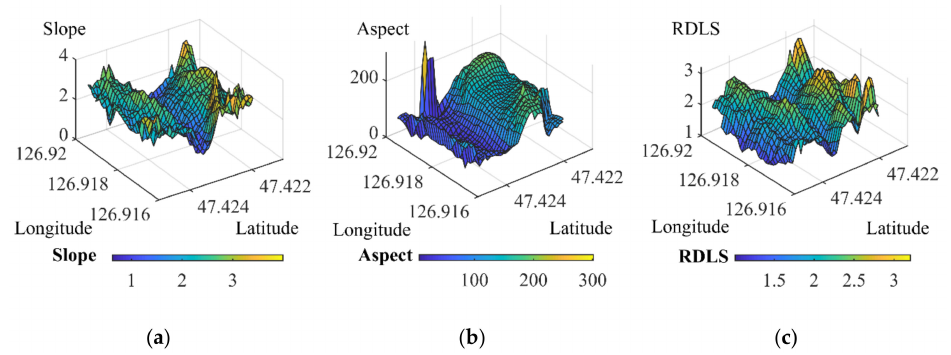
Figure 3. Spatial distribution characteristics of topographic factors (( a ): slope; ( b ): aspect; ( c ): relief degree of the land surface